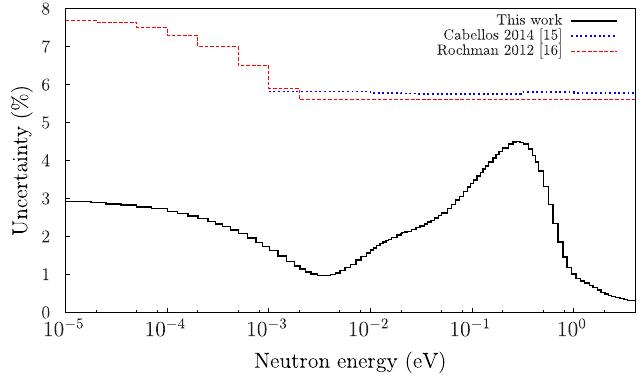
Fig. 1. Uncertainties in the inelastic cross section from this work, compared to previous